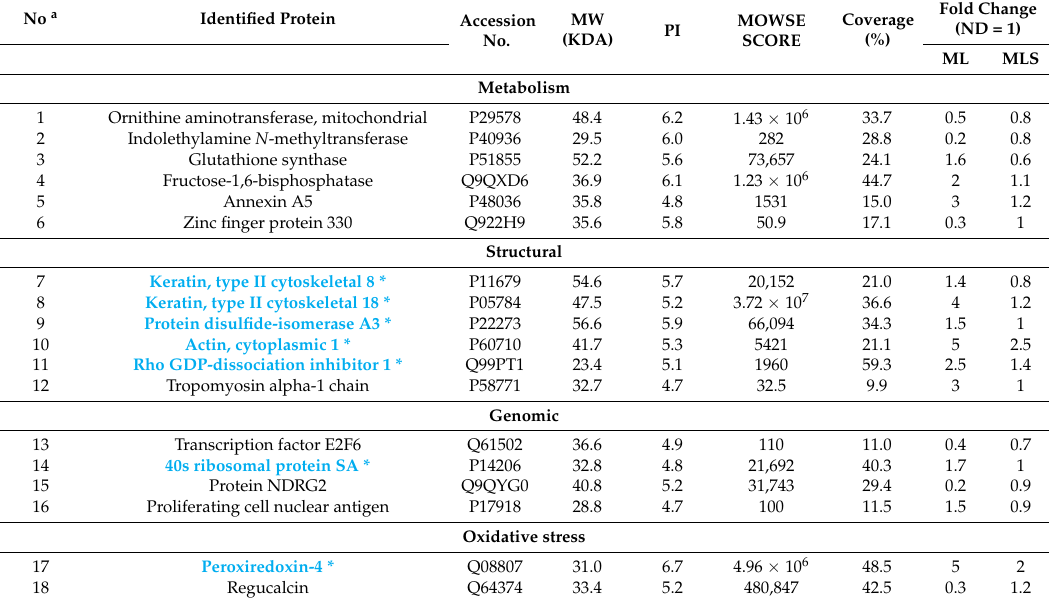
Table 1. Differentially expressed proteins